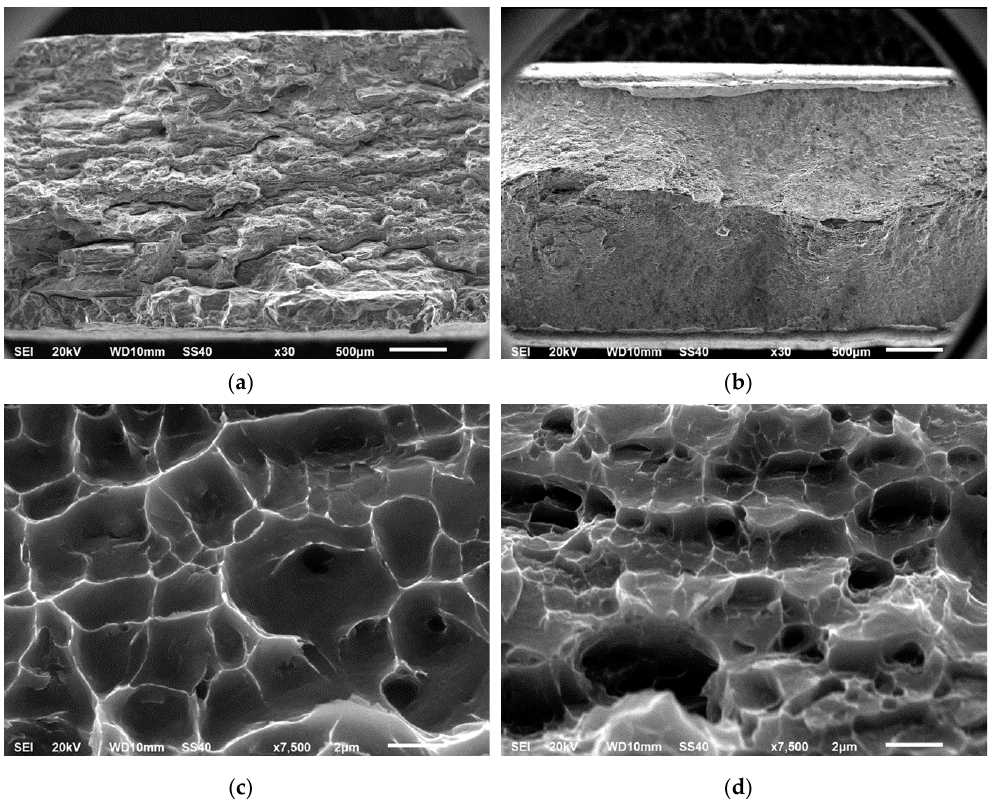
Figure 9. Fracture surface topography of AA 6005A specimens extruded at 500 °C treated in the peak- aging hardness condition after tensile tests. SEM macrographs of ( a ) I/M route and ( b ) P/M route, SEM micrographs of ( c ) I/M route and ( d ) P/M